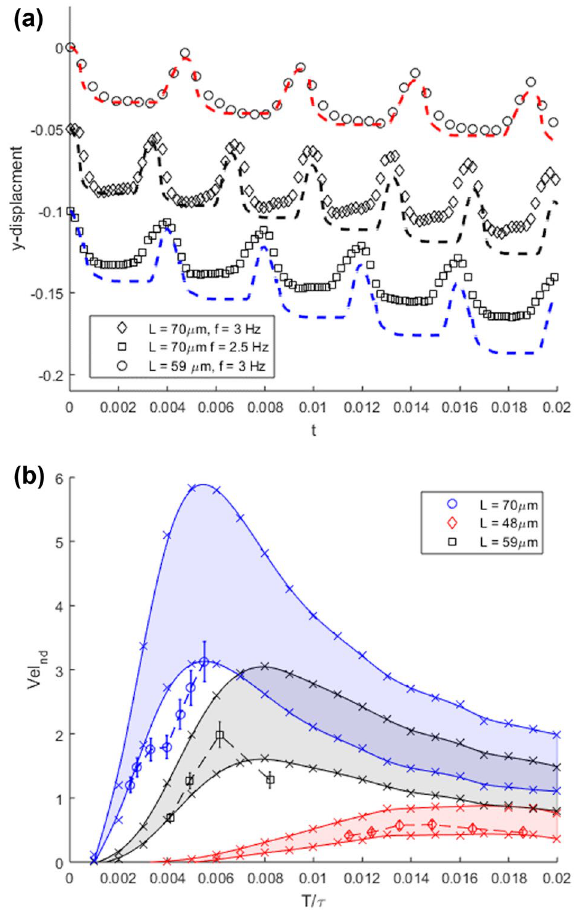
Figure 3. ( a ) Relationship between filament centre of mass y-displacements vs time, circle, diamond and square points donates experimental data. The displacement is scaled by the filament length on the y-axis and with τ = 54 s (diamond and square) and 42 s (circle) on the x-axis. The dashed shows the numerical filament centre with points that correspond to the experiment (black: Cm = 70 , T /τ = 0.0039 ), (blue: Cm = 70 , T /τ = 0.031 ) and (red: Cm = 50 , T /τ = 0.0047 ). ( b ) Scatter points: velocity vs frequency for filaments with lengths L = 48 µ m (diamond), 59 µ m (circle) and 70 µ m (square) scaled with L/ τ on y-axis and τ on the x-axis, operating at a range of frequencies and fixed field strength H = 5.2 Oe. The solid lines represent numerical simulations over range of T/ τ : Cm = 70 (Blue), Cm = 50 (Black) and Cm = 30 (red). Colored regions boundaries corresponds simulations by defining (cid:31) = − 0.2 and − 0.4 for lower and upper lines